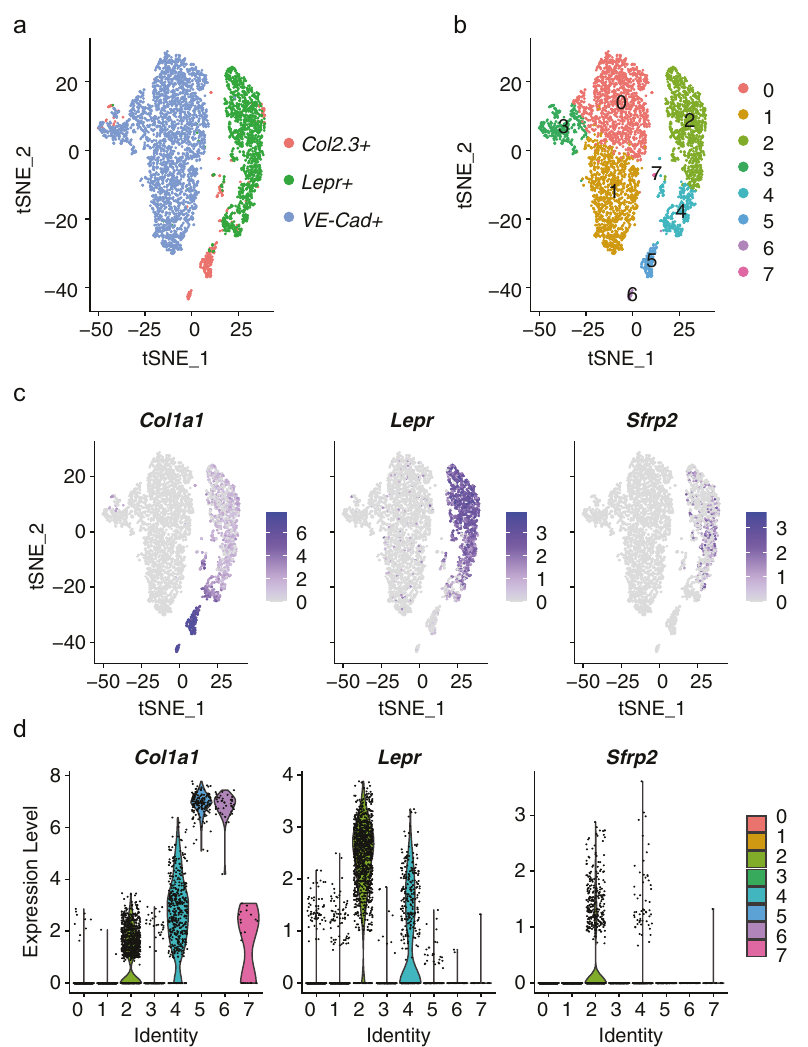
Fig. 1 Analysis of scRNA-seq data from previously published datasets 29 that assessed non-hematopoietic cell lineages of mouse bone marrow in steady state conditions. a tSNE plot of cre-induced osteoblasts ( Col2.3 + ; red), mesenchymal stromal cells ( Lepr + ; green), and vascular cells ( VE-Cad + ; blue) and ( b ) associated clusters. c , d Sfrp2 -expressing cells were found to be signi fi cantly enriched in cluster 2, a cluster containing the Lepr + skeletal stem/progenitors (termed “ mesenchymal stromal ” cell population by the authors) that also exhibited the greatest number of cells with a high magnitude of Lepr